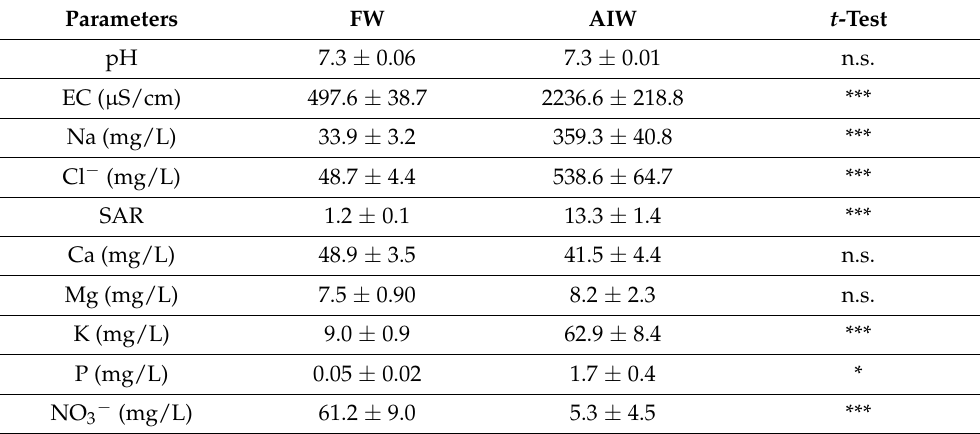
Table 2. Chemical parameters for both fresh water (FW) and Agro-Industrial wastewater (AIW). Each data represent the mean of 11 values ± the standard deviation measured on water samples collected during the 2020.